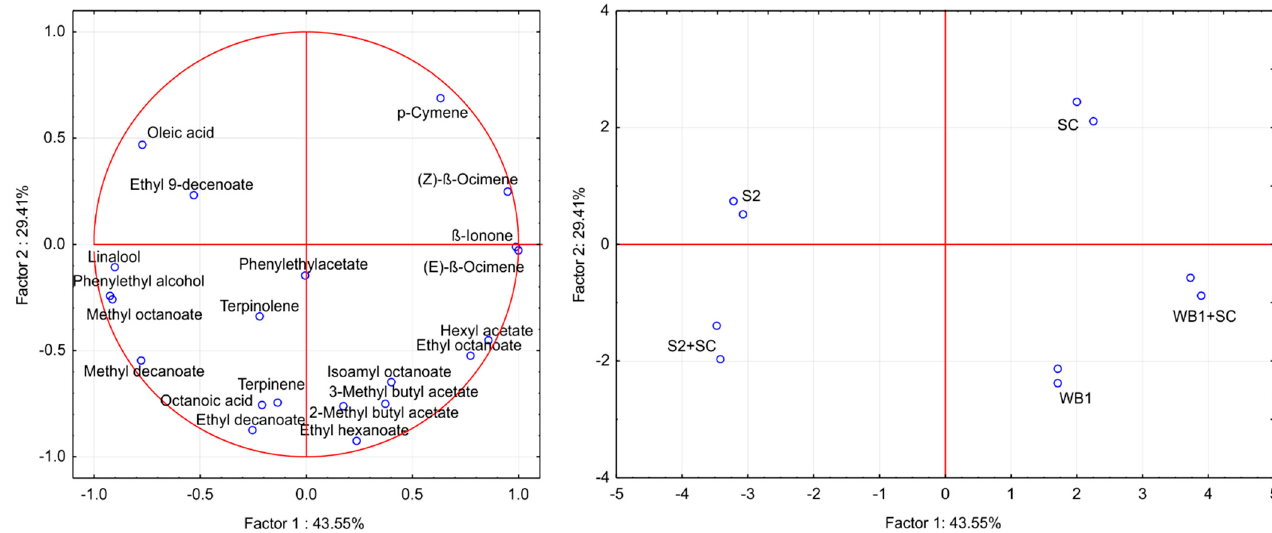
Figure 3. Principal component analysis (PCA) of volatile compounds (OAV > 1) from Tamjanika wine samples fermented in pure or sequential inoculation with C. famata WB-1 , H. uvarum S-2, and wine samples fermented in pure or sequential inoculation with C. famata WB-1, H. uvarum S-2,